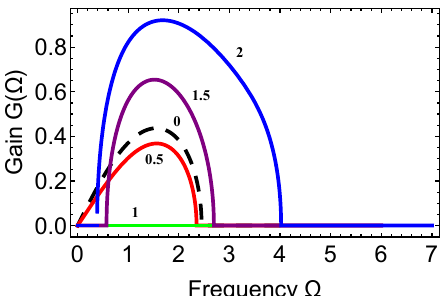
Figure 12. The MI gain spectra for different values of the group-velocity mismatch (walk-off) between the cores in the mixed-GVD coupler ( α < 0) for P = κ = 1, η = 0.5, α = − 0.1, Γ =